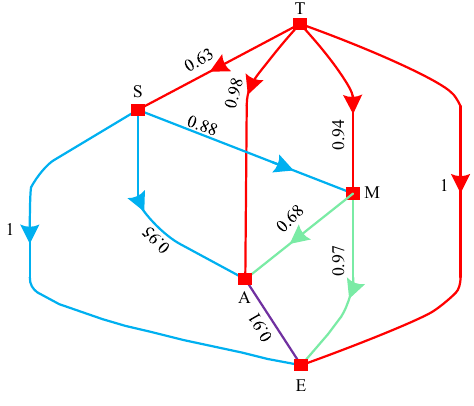
Figure 4. The weight-directed graph for different